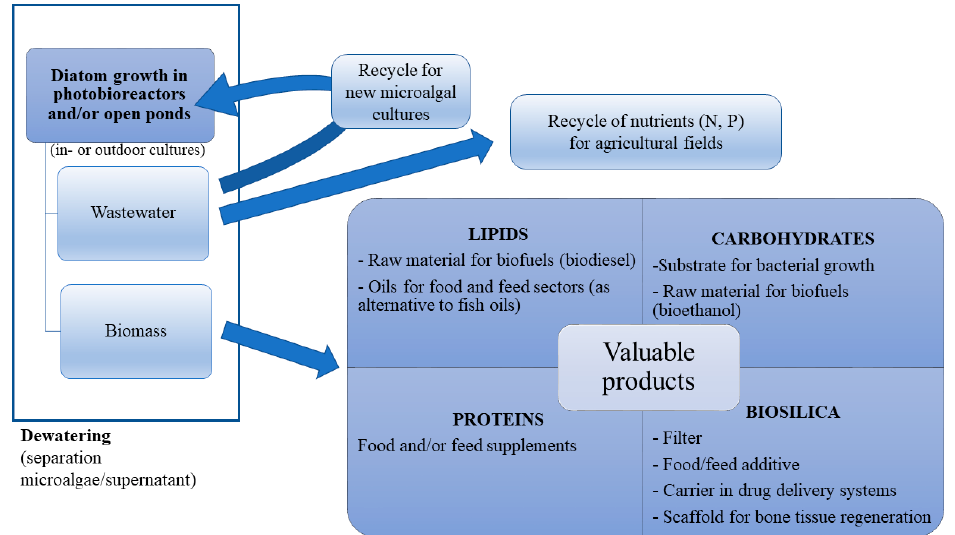
Figure 3. Schematic representation of a hypothetic diatom-based biorefinery for the whole exploita- tion of microalgal mass. Diatoms are cultured in open ponds or photobioreactors; after harvesting, the remaining water is still rich in nutrients and can be partially reused as medium for new culture inocula or serve as agricultural fertiliser. Four major valuable products, lipids, proteins, carbohydrates, and biosilica can be obtained from the harvested biomass.